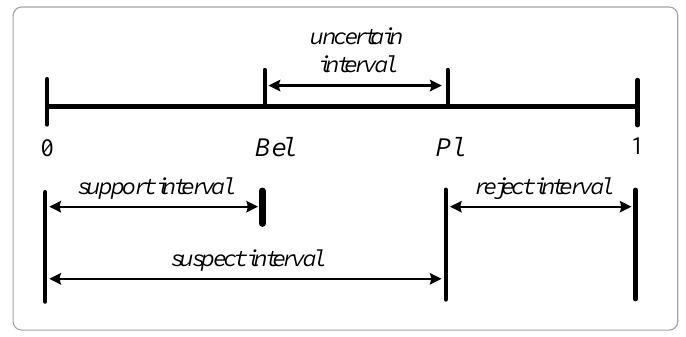
Figure 2. Uncertainty representation of the